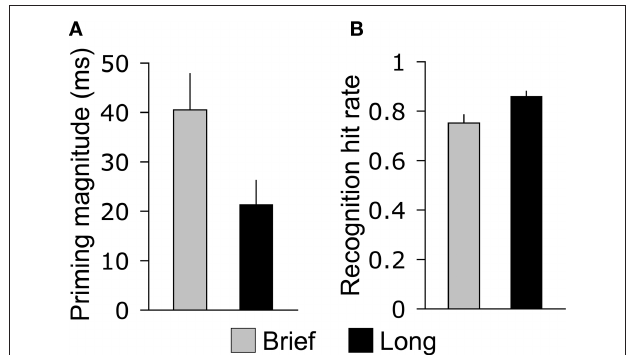
Figure 2 | Opposite effects of study duration on priming and recognition. (A) The average difference between old and new objects in categorization response time during the memory test is shown for Brief and Long objects. (B) The average hit rate for the recognition response is shown for Brief and Long objects, collapsed across high- and low-confidence levels. Error bars indicate